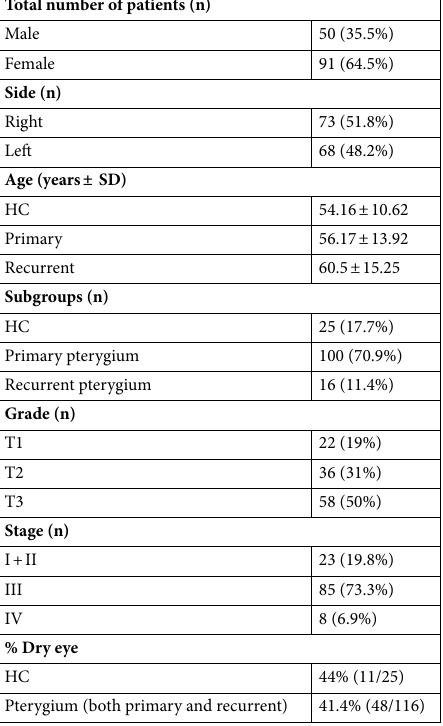
Table 1. Patient demographic and clinical characteristics. HC = healthy control; grade of pterygium according to fleshy and translucency by Tan et al. classification; stage of pterygium according to extension of pterygium by Johnston, Williams, and Sheppard classification